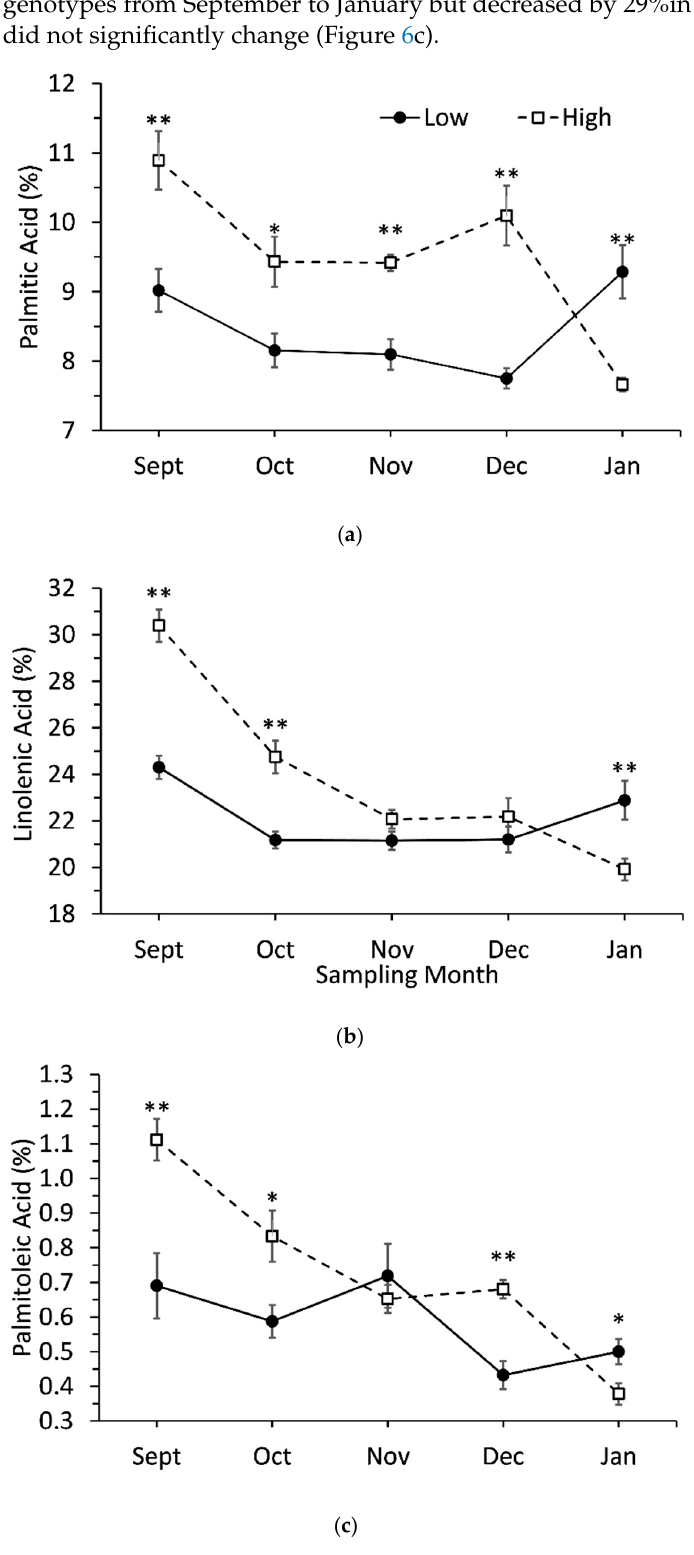
Figure 5. Interactive effects between balsam fir genotype (low and high needle abscission resistance) and sample collection date for ( a ) linoleic acid, ( b ) oleic acid, ( c ) pinolenic acid, and ( d ) and arachidic acid. Each data point represents a mean ± standard error as calculated from of 10 branches. The * indicated 1% to 5% significance and the ** indicates less than 1% significance between genotypes at any month.